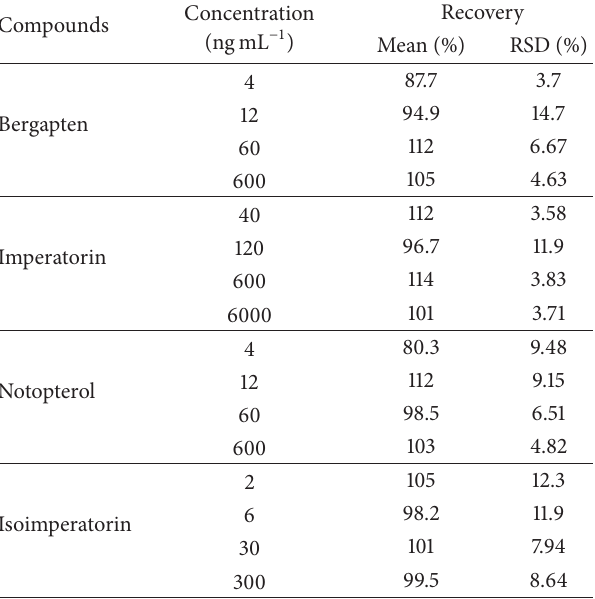
Table 2: Extraction recovery of four coumarins in rat plasma ( 𝑛 = 6